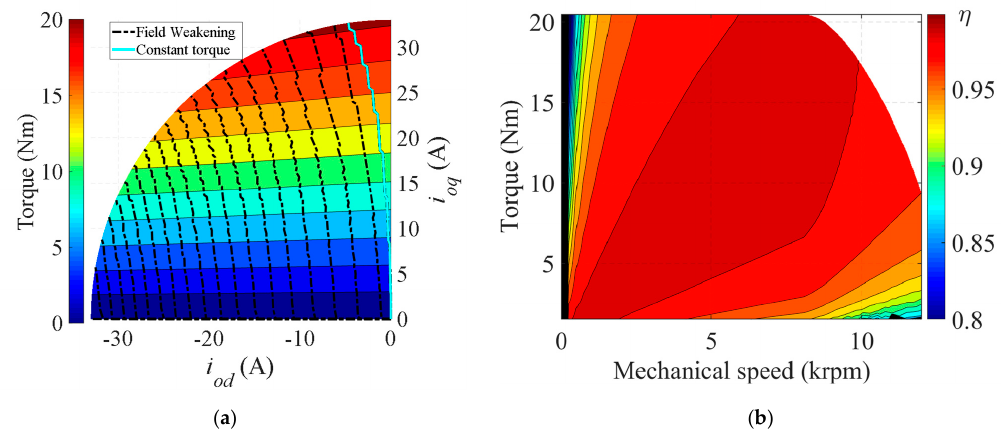
Figure 16. Optimized solution's performance: ( a ) torque map and ( b ) efficiency map.